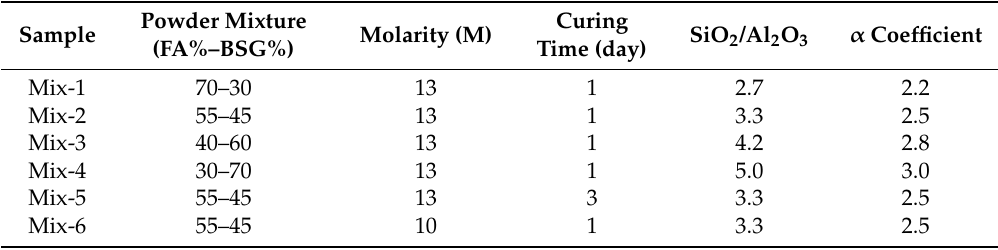
Table 1. Summary of the methodology of preparation of the fly ash (FA) and borosilicate (BSG) based geopolymer samples and related